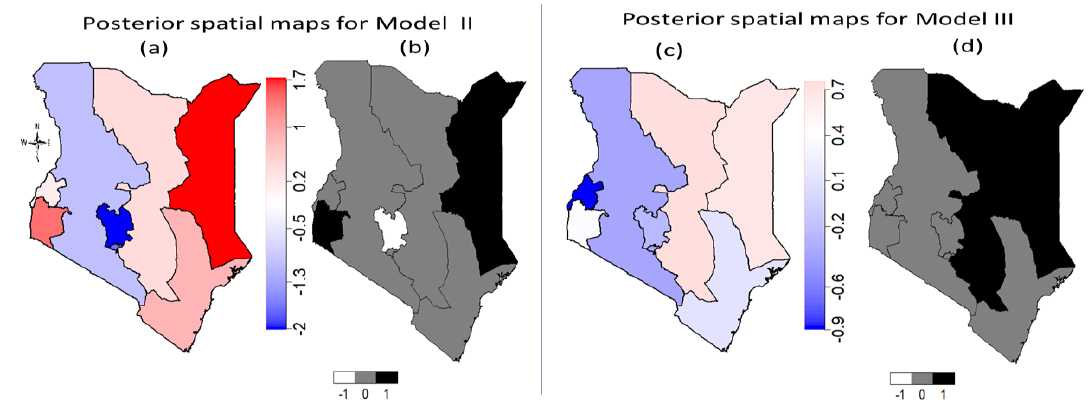
Figure 6. Posterior risk maps (( a ) and ( c )) of Kenyan 0–14 years old girls’ FGM / C with the corresponding 95% (right ( b ) and ( d )) posterior significance maps for Model II (left panel) and Model III (right panel). Deep blue to red corresponds to low risk to high risk. Black colour in ( b ) and ( d ) indicates significantly high-risk regions, white colour indicates significantly low risk regions and grey colour indicates nonsignificant regions. Evidence from the pooled 2003 to 2014 KDHS.